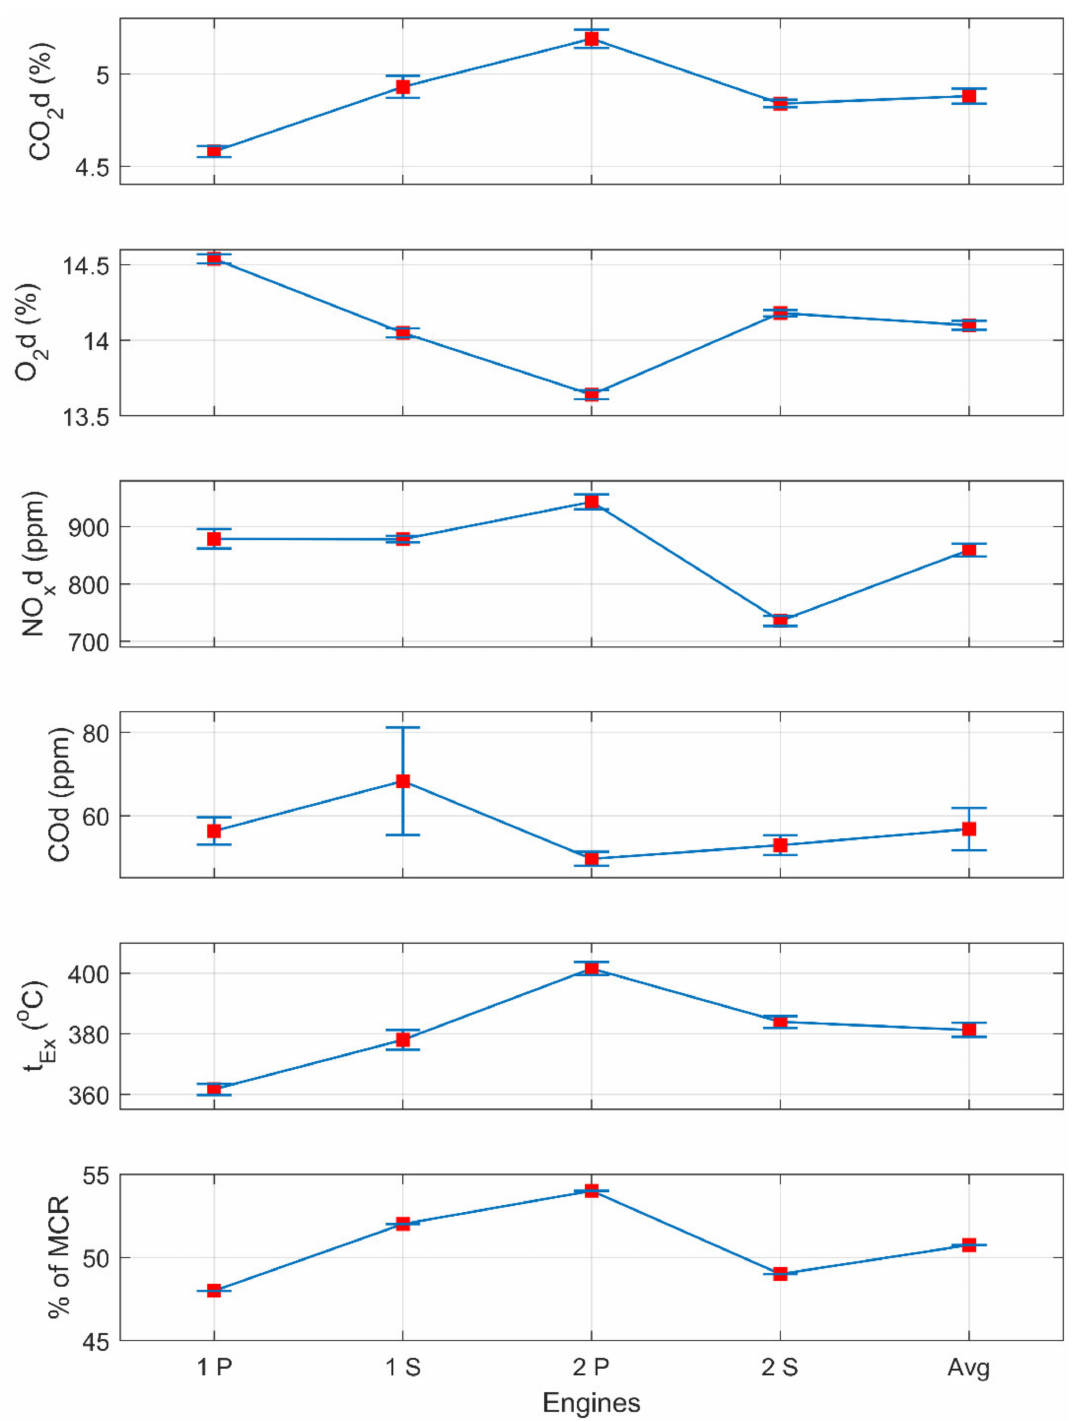
Figure 9. Mean µ and standard deviation σ of measured and analysed parameters for Vessel 3 and its associated port (P) and starboard (S) engines with calculated average